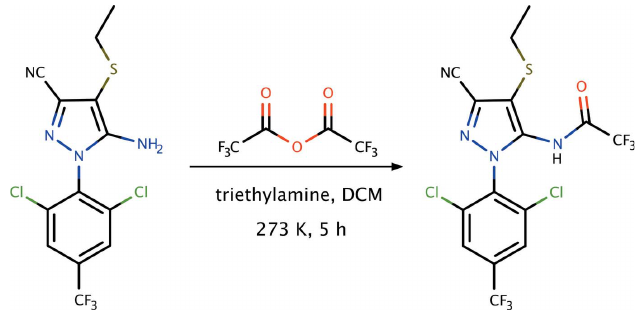
Figure 6 The overall reaction scheme for the synthesis of I